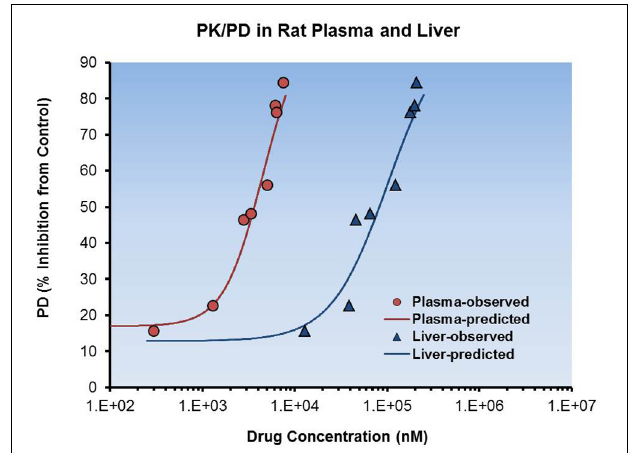
FIGURE 9 | Total plasma and liver exposures relative to pharmacodynamics response. Rat total plasma and target tissue (liver) exposure was plotted with PD effect. A sigmoidal E max model with baseline and Hill coefficient ( γ ) correction factors was used to describe the dataset. Improved in vitro-in vivo correlation was obtained when converting total plasma concentration to free plasma concentration for the estimate of in vivo EC 50